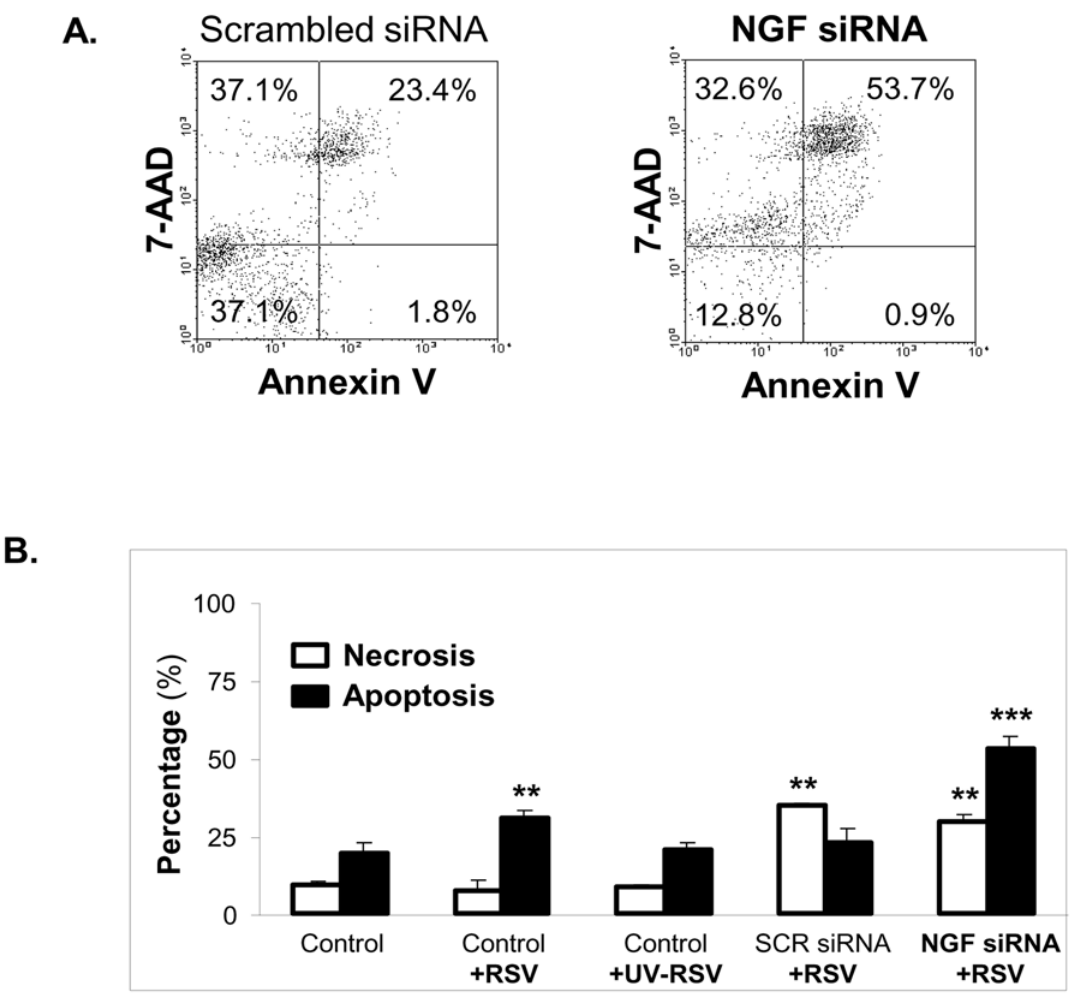
Figure 8. Apoptosis vs. necrosis in RSV-infected bronchial epithelial cells after NGF knock-down. (A). Dot plots of simultaneous annexin V and 7-aminoactinomycin D (7-AAD) staining of rgRSV-infected bronchial epithelial cells transfected with scrambled (SCR) siRNA (left) or with NGF- specific siRNA (right). After 48 h of transfection, cells were infected with 5 MOI of rgRSV. Apoptosis and necrosis were detected by DNA labeling with 7-AAD-PE and annexin V-Cy3 respectively. Data are expressed as percentage (%) of total cells. (B). Apoptosis vs. necrosis assessed by annexin V and 7- AAD staining followed by flow cytometry. Non-transfected controls include non-infected, rgRSV-infected, and UV-RSV-exposed cells. Data are expressed as the mean 6 SEM (n=3 experiments). **= p , 0.01; ***= p , 0.001 compared to non-infected